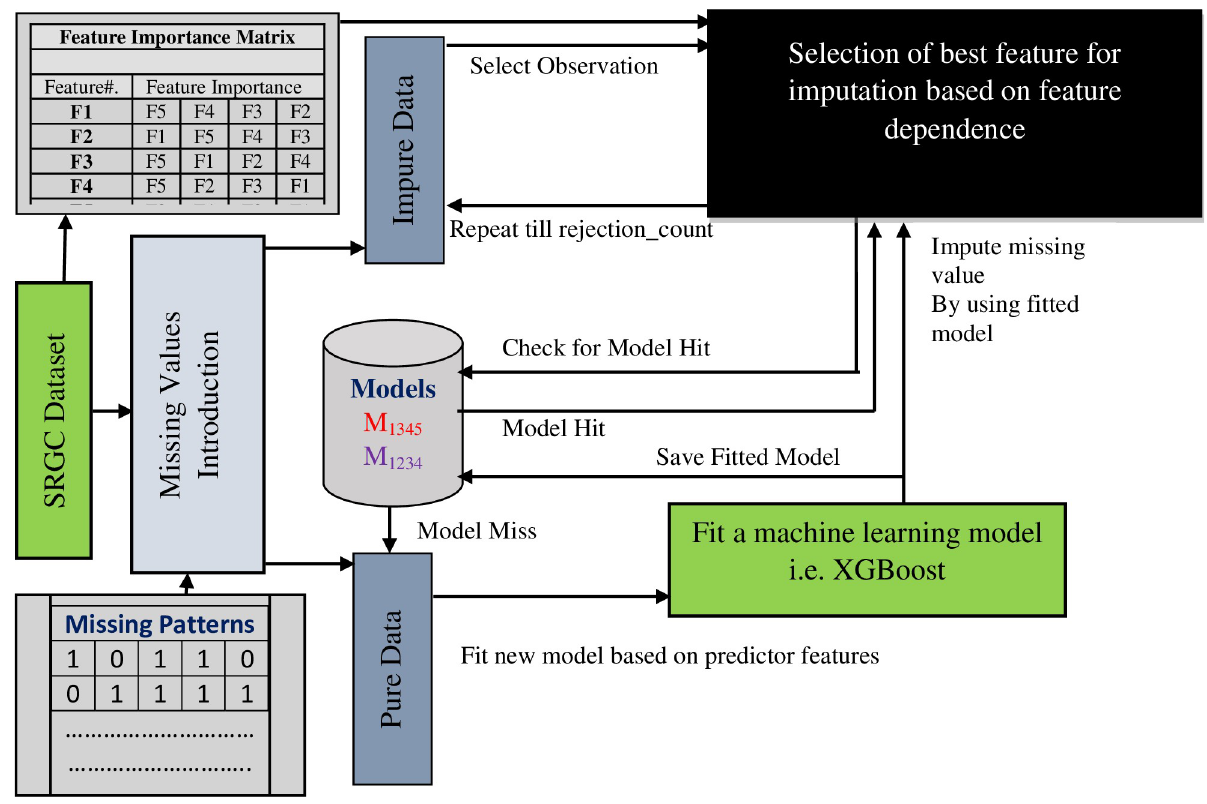
Fig 3. Proposed methodology to envelop base learning algorithm for imputation.